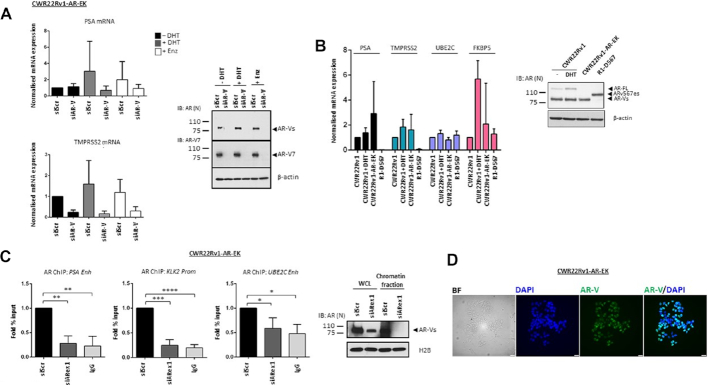
AR-Vs maintain androgenic signalling and bind chromatin in the absence of FL-AR. (A) CWR22Rv1-AR-EK cells grown in steroid-depleted media were subject to control (siScr) or AR-V (siAR-V) depletion for 48 hours with either vehicle, 10 nM DHT or 10 μM enzalutamide (Enz) treatment for the final 24 hours before quantitative RT-PCR analysis to assess PSA and TMPRSS2 expression. Data represents the average of three independent experiments ± SD. Validation of AR-V depletion is shown in the accompanying immunoblot (right panel) incorporating N-terminal-binding AR, AR-V7 and β-actin antibodies. (B) Comparison of PSA, TMPRSS2, UBE2C and FKBP5 in CWR22Rv1 cells grown in steroid-depleted media supplemented with or without 10 nM DHT, and CWR22Rv1-AR-EK and R1-D567 cells grown in steroid-depleted media by quantitative RT-PCR. Data represents the average of three independent experiments ± SD. Accompanying immunoblot (right panel) of the three cell lines grown in the presence and absence of 10 nM DHT shows AR and β-actin levels. (C) CWR22Rv1-AR-EK cells were subject to control (siScr) or AR (siARex1) knockdown for 48 hours before ChIP experiments incorporating either N-terminal AR-binding or control (IgG) antibodies. Data represents the average of three independent experiments ± SD (*, **, ***, **** represent P< 0.05, 0.01, 0.001 and 0.0001, respectively as determined using one-way ANOVA). Accompanying immunoblots (right panel) of CWR22Rv1-AR-EK whole cell lysates (WCL) and chromatin fractions, incorporating AR and histone H2B antibodies, demonstrates successful depletion of AR-Vs in siARex1-transfected cells. (D) Representative bright field (BF) and immunofluorescence images using an anti-AR antibody (left panel) and DAPI counterstain (right panel) in CWR22Rv1-AR-EK cells. Scale bars are 25 μm.